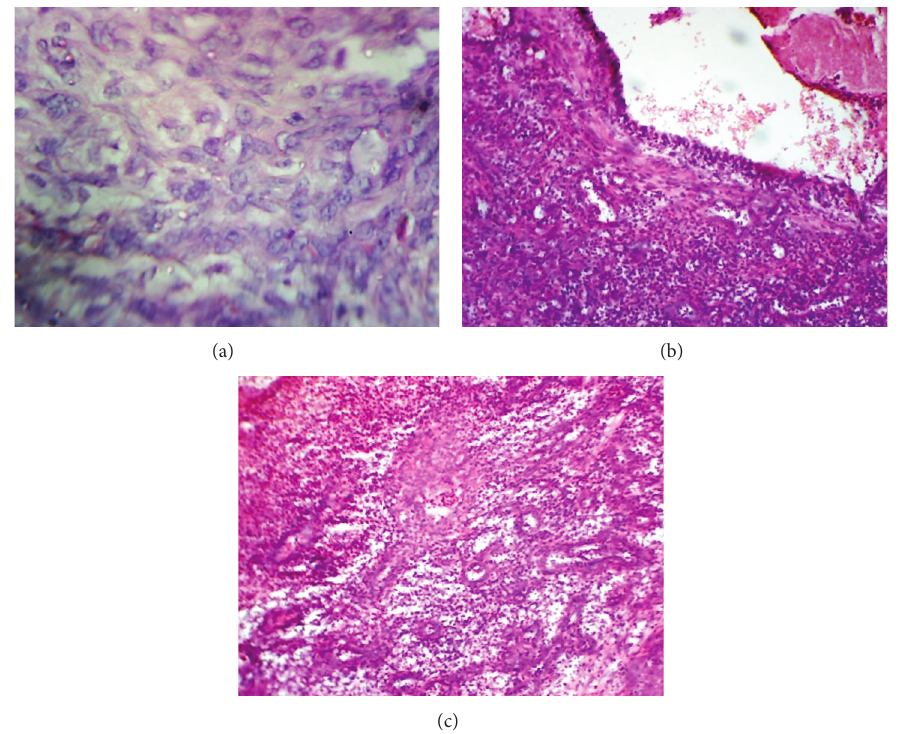
Figure3: (a)Histopathological pictureshowing sheets ofepitheliod cells (arrows);H&E, × 400 (originalmagnification). (b) Histopathological picture showing plump epithelioid cells lining blood vessel in tombstone appearance (arrows); H&E, × 100 (original magnification). (c) Histopathological picture showing eosinophils in connective tissue stroma (arrows); H&E, × 400 (original magnification).